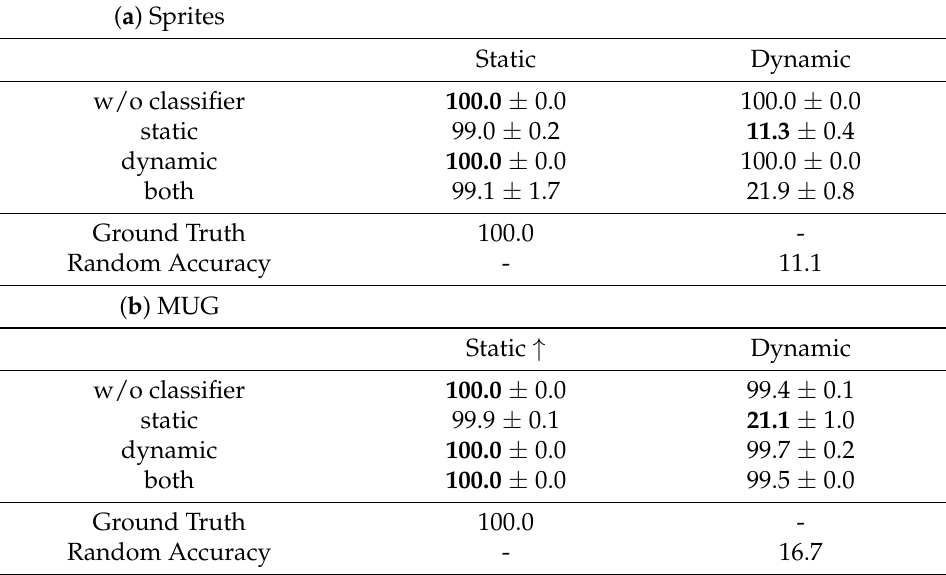
Table A1. Average classification accuracy over ten runs for fixed static features and randomly sampled dynamic features